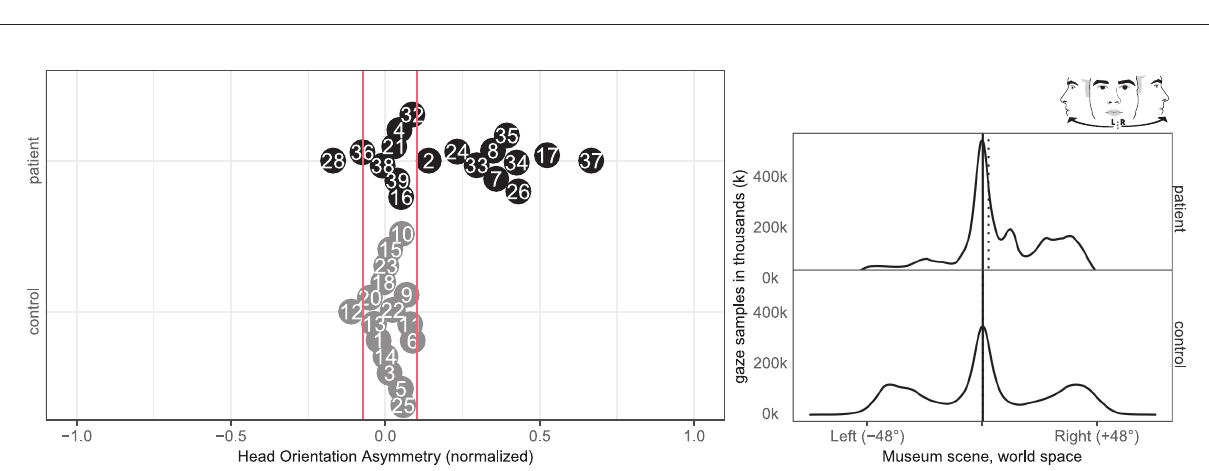
FIGURE 6 | Head orientation left/right. (Left) Individual time spent rotating head left and right in patient (black, top) and control (gray, bottom) with normative threshold cut-offs (red lines). (Right) Spatial distribution of patient and control head orientation with true (solid) midline and group median (dotted).